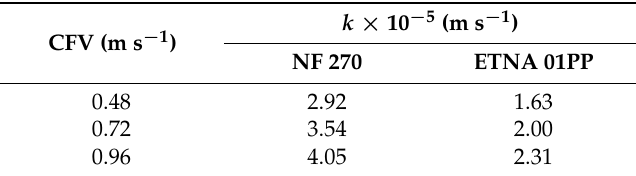
Table 3. Mass-transfer coefficients obtained through the Rosa correlations, k , for NF 270 (Equation (9)) and ETNA 01PP (Equation (8)) membranes at different cross-flow feed